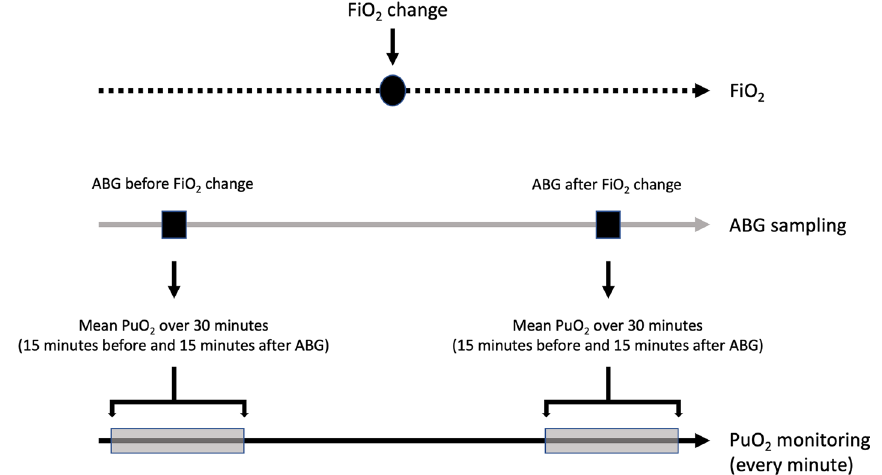
inspired oxygen; PuO 2 : urinary oxygen